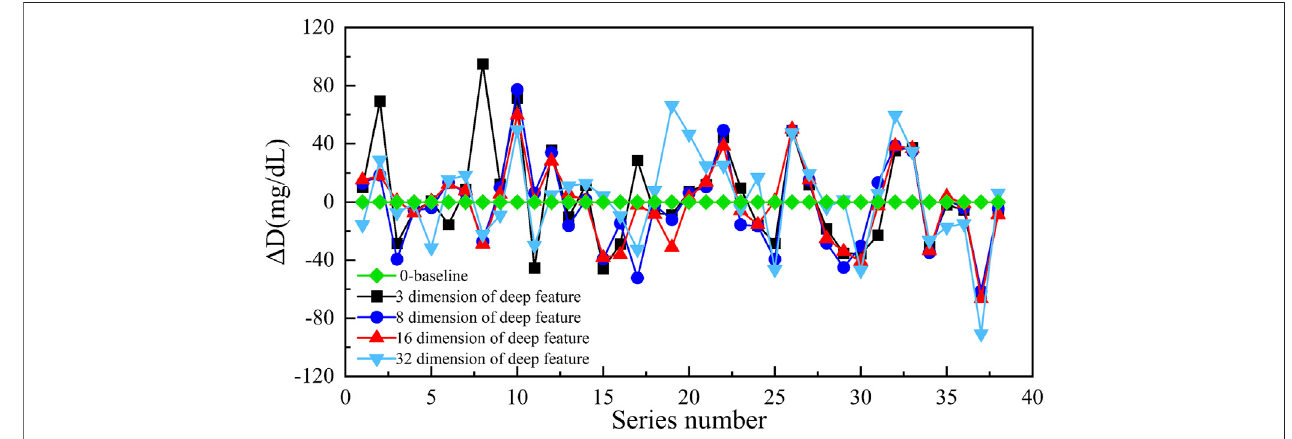
TABLE 2 | The prediction results of different dimension of deep features. Dimension of deep features